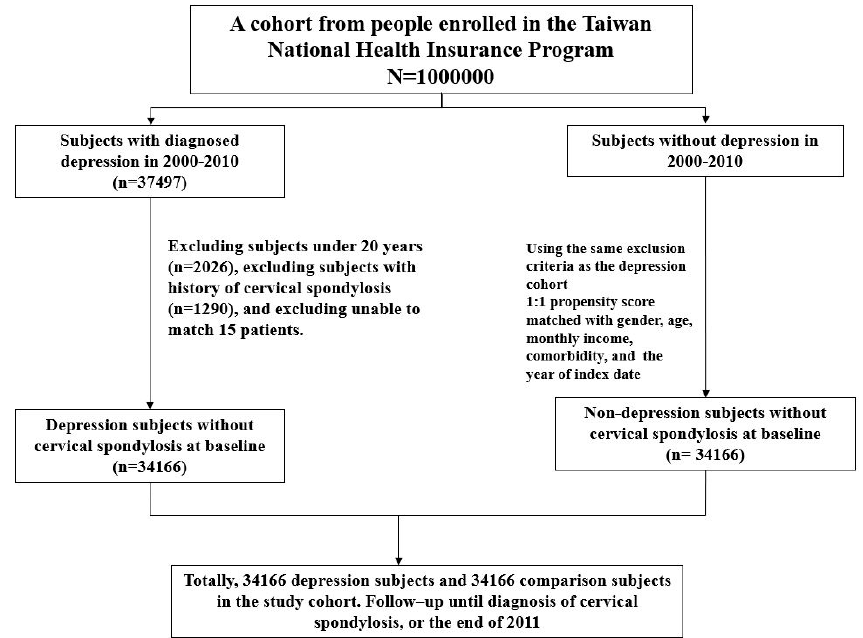
Figure 1. Flow chart for establishing study cohorts.